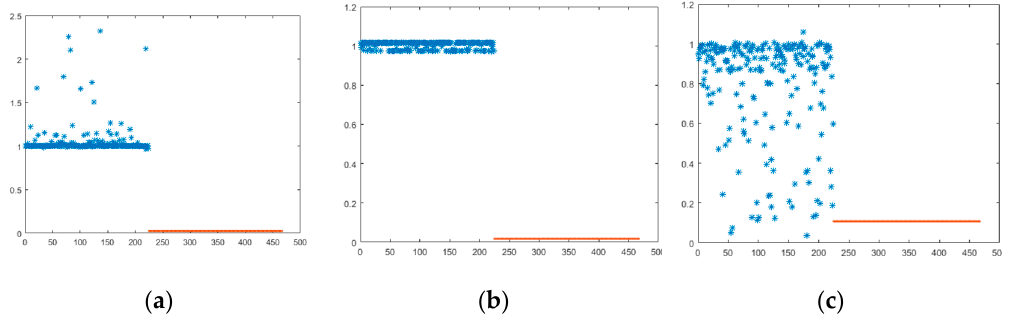
Figure 7. Probability distribution of simulation result for different-dimensional Log-Gabor features: ( a ) 6144-dimensional Log-Gabor features for NMFsc; ( b ) 1536-dimensional Log-Gabor features for NMFsc; ( c ) 12-dimensional Log-Gabor features without NMFsc.